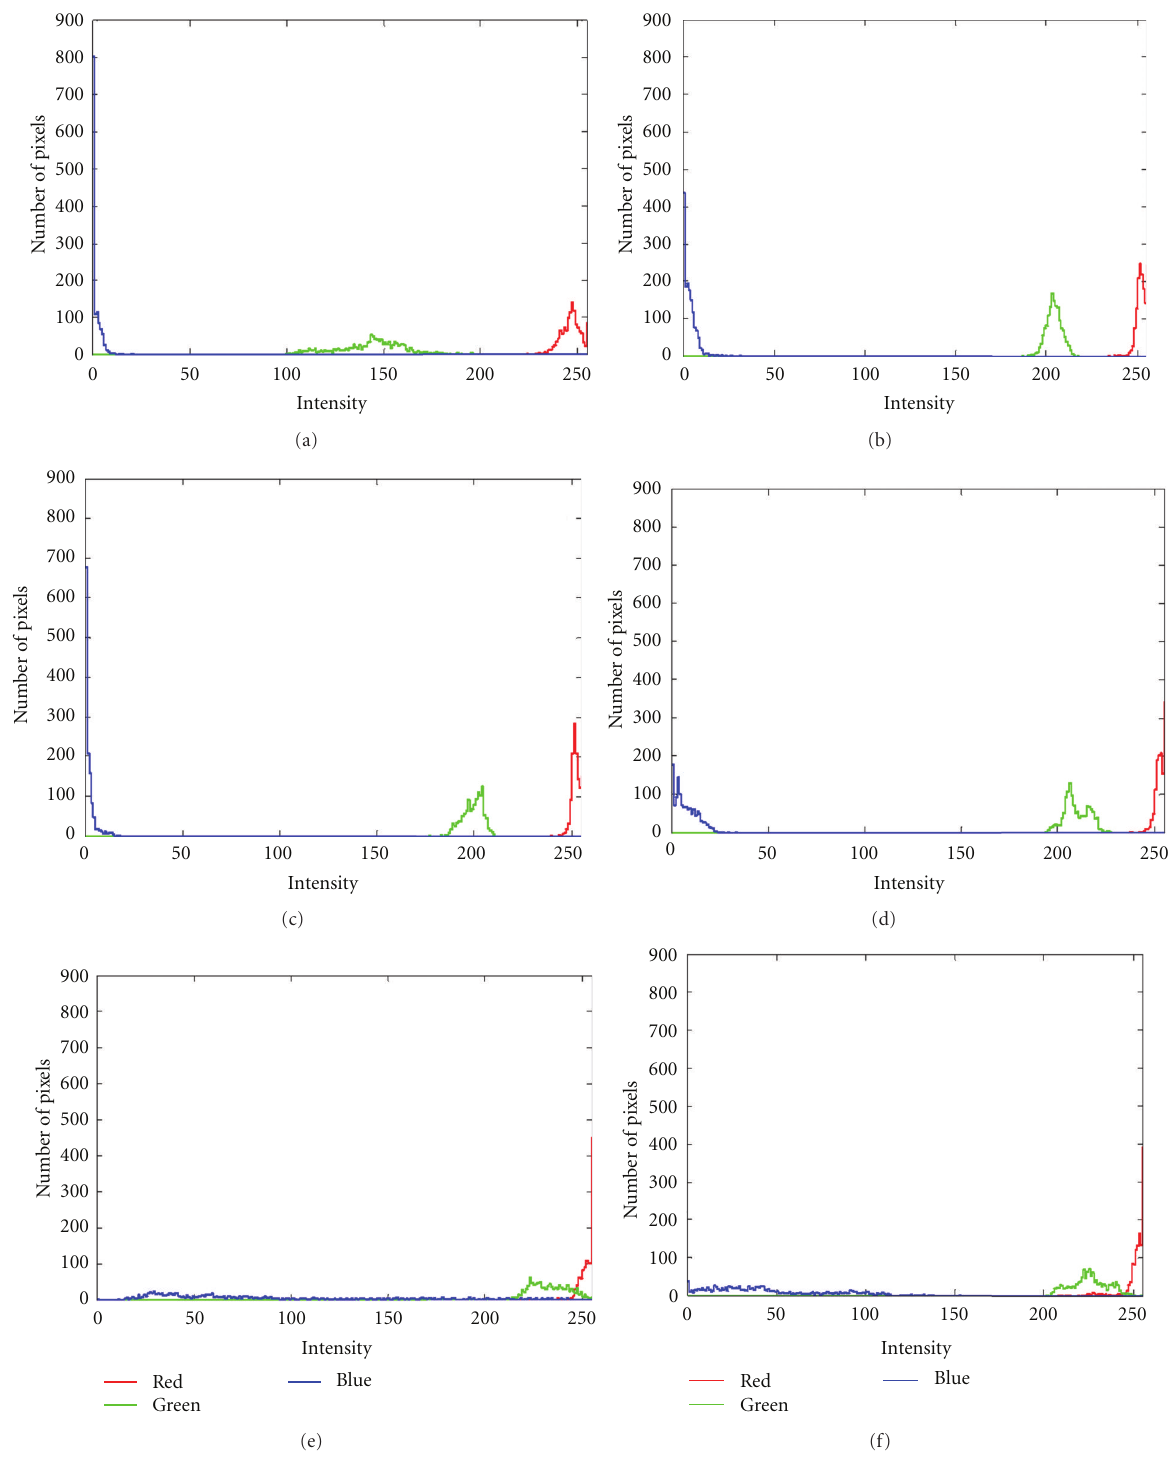
Figure 4: RGB histogram of single rat thermal image in di ff erent regions (a) lower right (tumor induced) flank region, (b) lower left flank region, (c) right abdomen region, (d) left abdomen region, (e) right shoulder region, and (f) left shoulder region. Red and blue pixel distributions were symmetrical between right and left sides in tumor induced flank region except green pixel distribution (asymmetrical). All red, green, and blue pixel distributions were symmetrical between corresponding right and left sides in nontumor sites (abdomen and shoulder